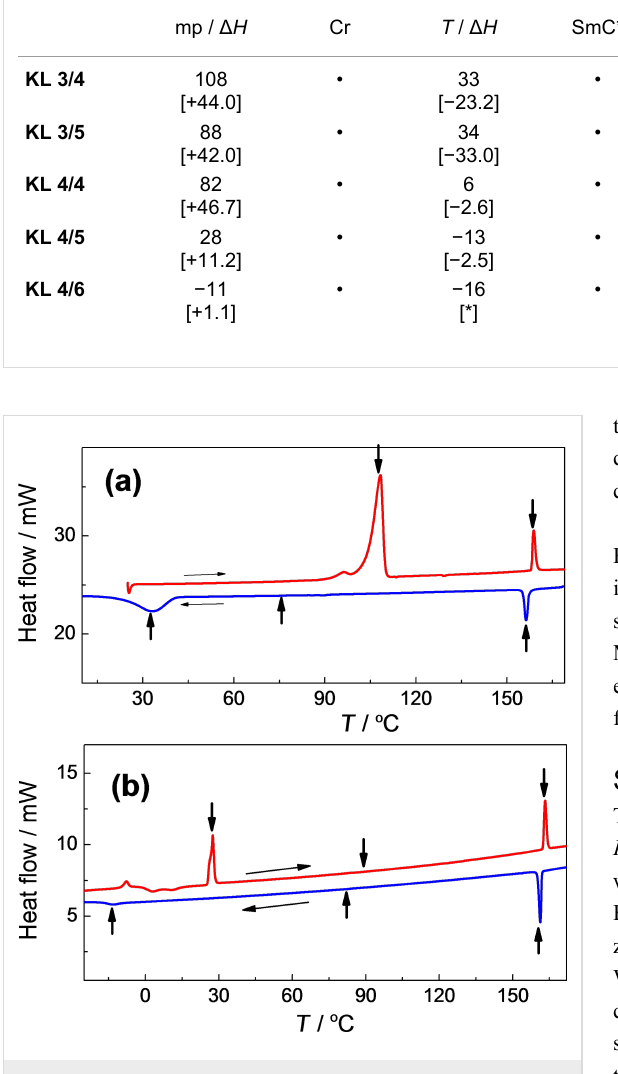
Figure 1: Differential scanning calorimetry (DSC) plot of heating/cool- ing runs (indicated by horizontal arrows) for KL3/4 (a) and KL 4/5 (b). Vertical arrows indicate the peaks corresponding to phase